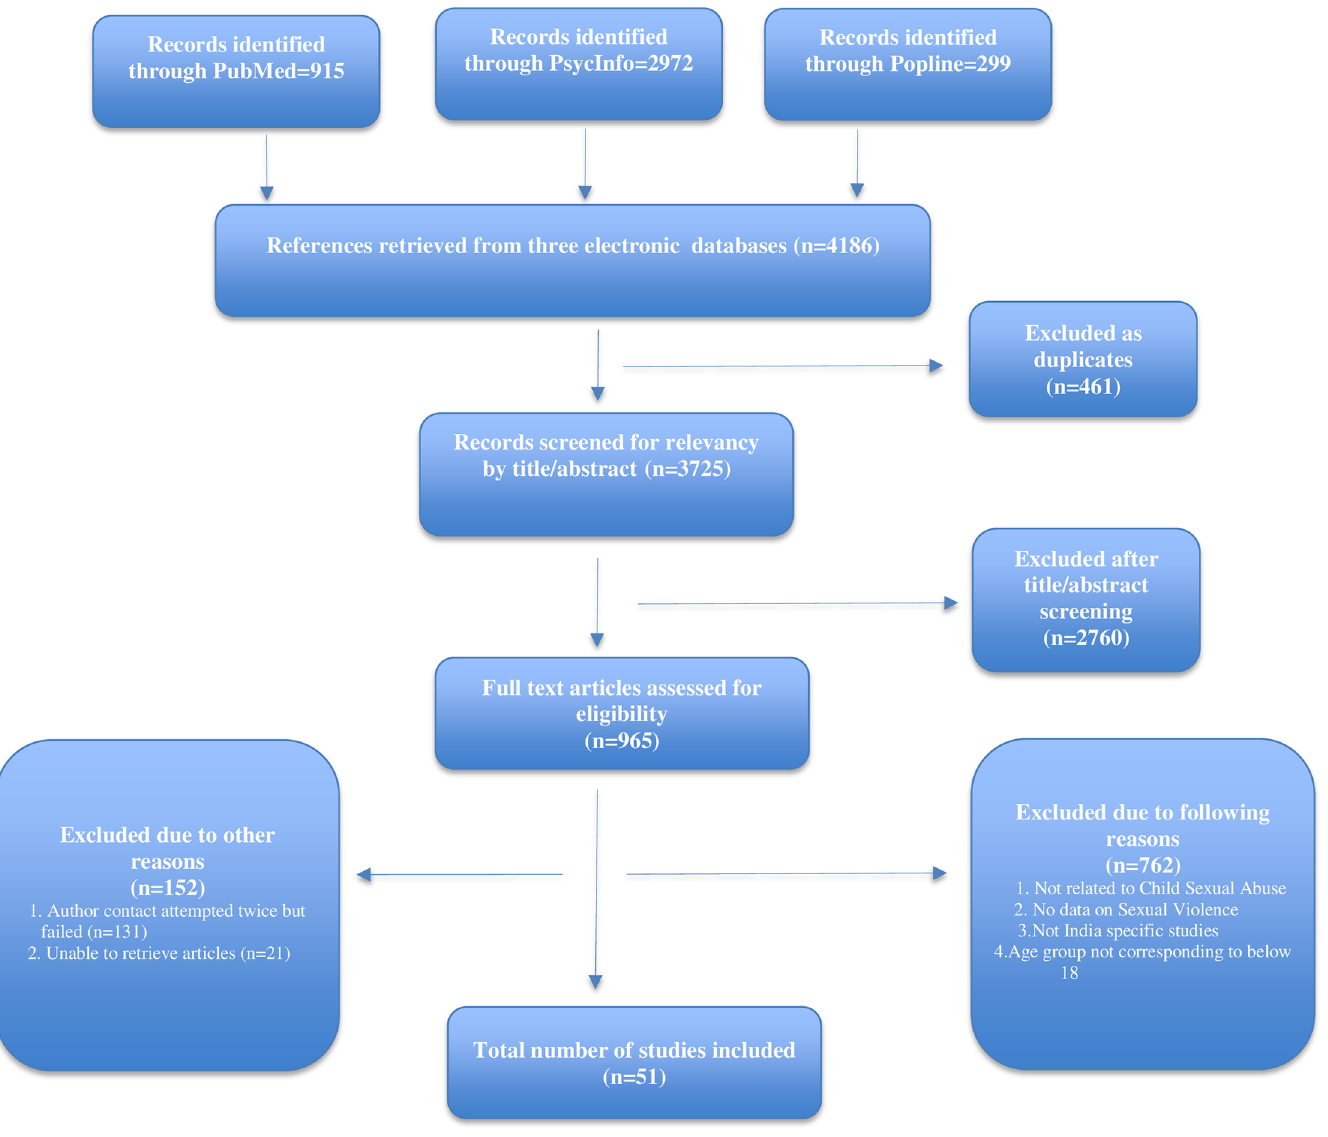
Fig 1. Adapted PRISMA flow chart demonstrating study selection and filter